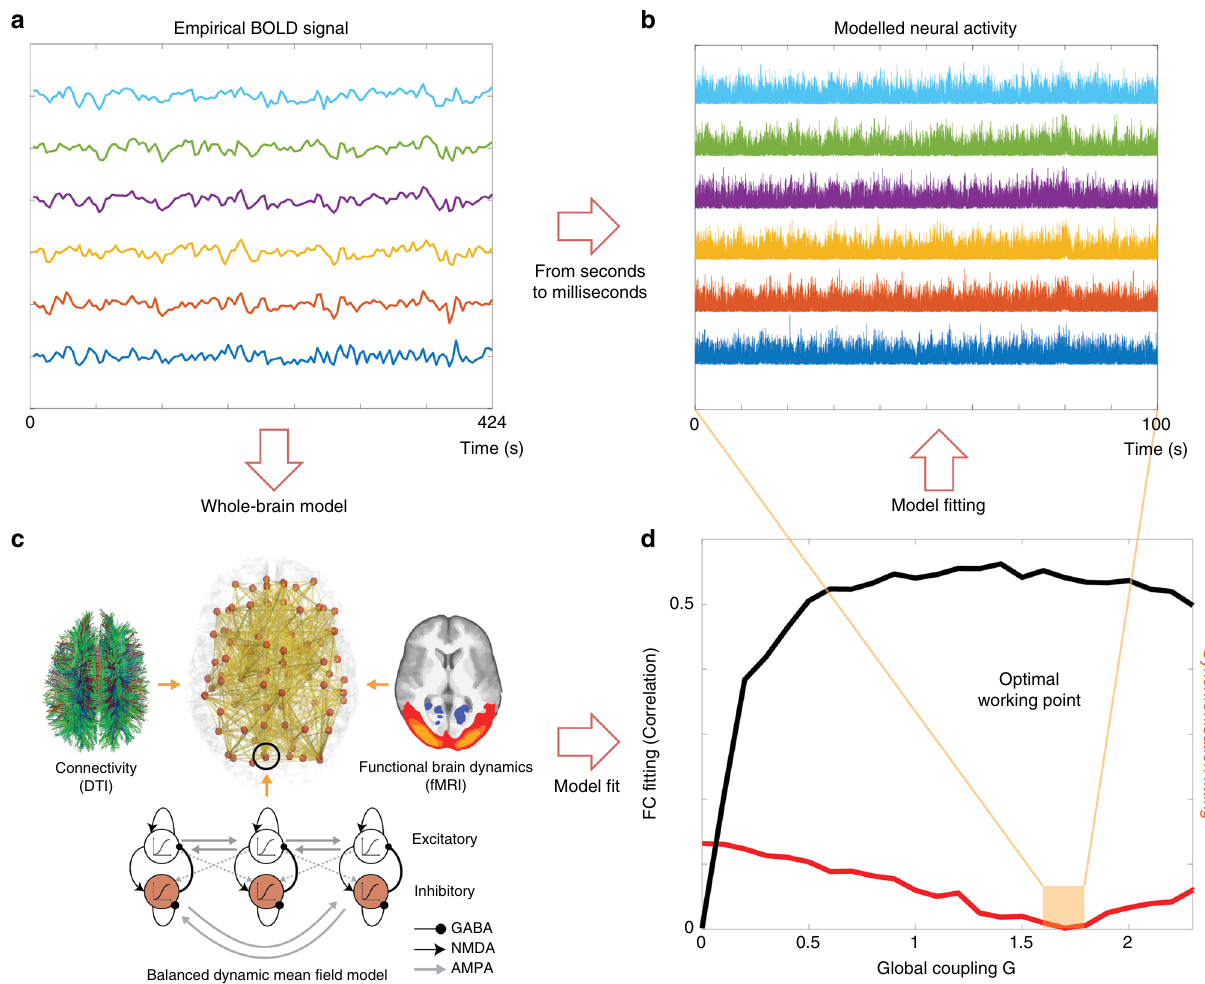
Fig. 1 General whole-brain modelling scheme for generating milliseconds time series from BOLD data. a Extracting the BOLD time series from fMRI with a typical time scale of 2 s. b These BOLD time series are generated by neural activity on the scale of milliseconds. This scale is fundamental to be able to investigate the relevant time scale of brain activity. c The transformation from slow to fast time scale is accomplished by whole-brain modelling, where we use the slow data to fi t a balanced dynamic mean fi eld model with realistic synaptic dynamics and shaped by the underlying anatomical skeleton. d The optimal working point of the model is found using the optimal global synchronisation level (red line shows the quadratic error of the difference between the empirical and simulated Kuramoto order parameters, see Methods) and fi tting to the static functional connectivity (FC, black line shows the correlation between the empirical and simulated static FC matrices). At the optimal working point (corresponding to the minimum of the synchronisation fi t, shown in orange box), the model generates the milliseconds time series which is used to fi nd the relevant